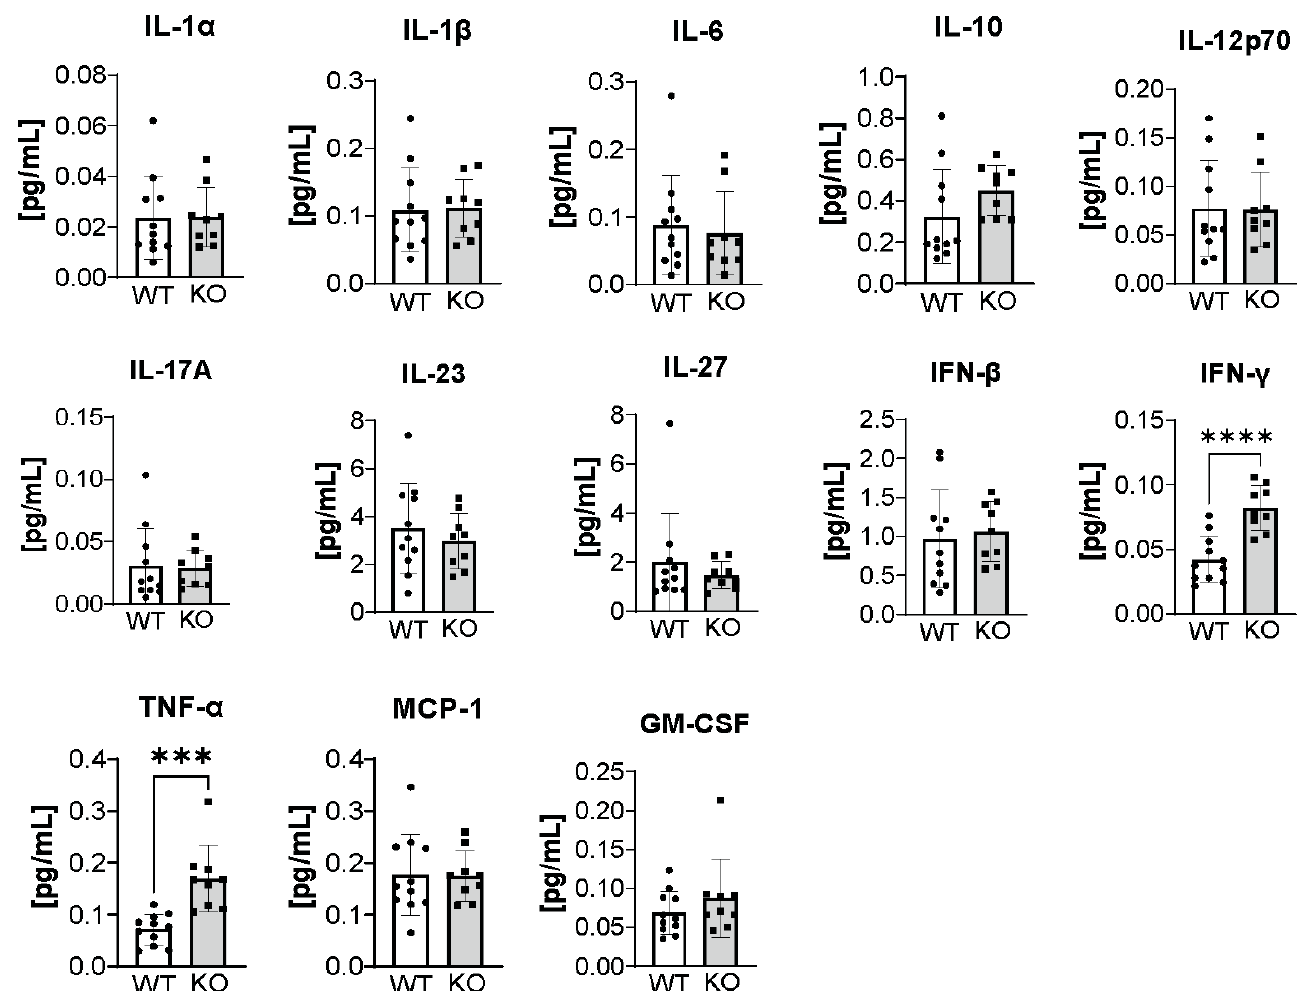
Figure 6. Cytokine measurements in the plasma of Sftpc-WT and Sftpc-KO mice on post-inoculation day 21. Flow cytometry was performed to compare the concentration of 13 cytokines in the plasma of Sftpc-WT (white bars) and Sftpc-KO (gray bars) mice, on day 21 post-inoculation, inoculated with 1.5 × 10 5 ATX-KO B16-F10 cells. Sftpc-KO mice presented an increase in 2 out of the 13 cytokines (unpaired t -test, IFN γ , **** p < 0.0001; TNF α , *** p = 0.0003).